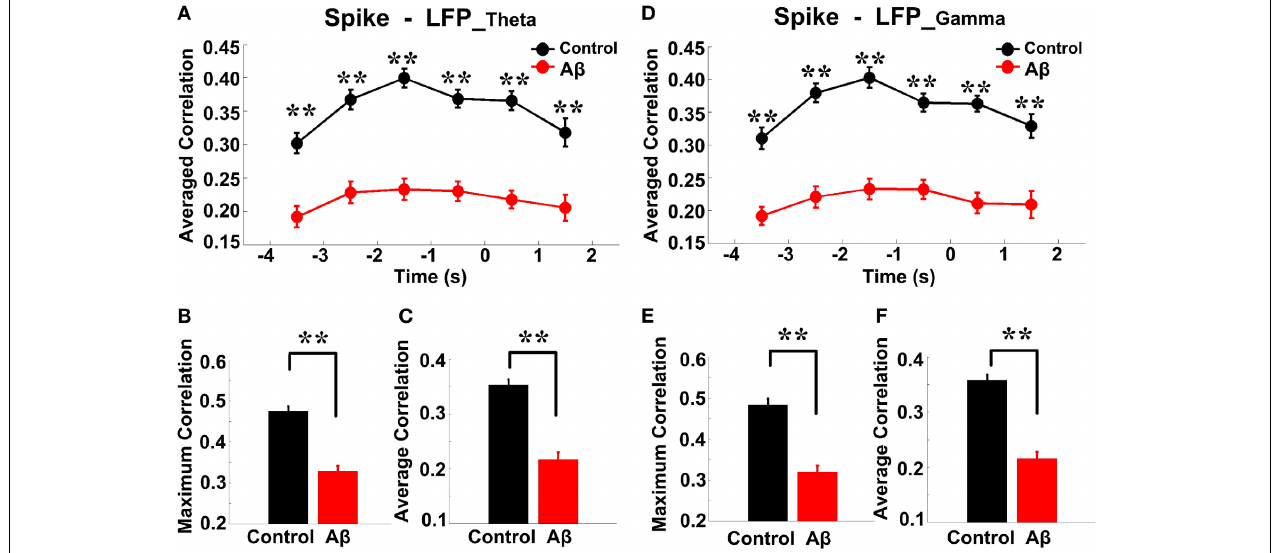
FIGURE 8 | Entropy correlation between spikes and LFPs during the working memory task in the A β ( n = 56) and control ( n = 56) groups. (A) Averaged entropy correlations between spikes and theta band LFPs (black: control; red: A β ). Data were averaged across all the trials within each group;